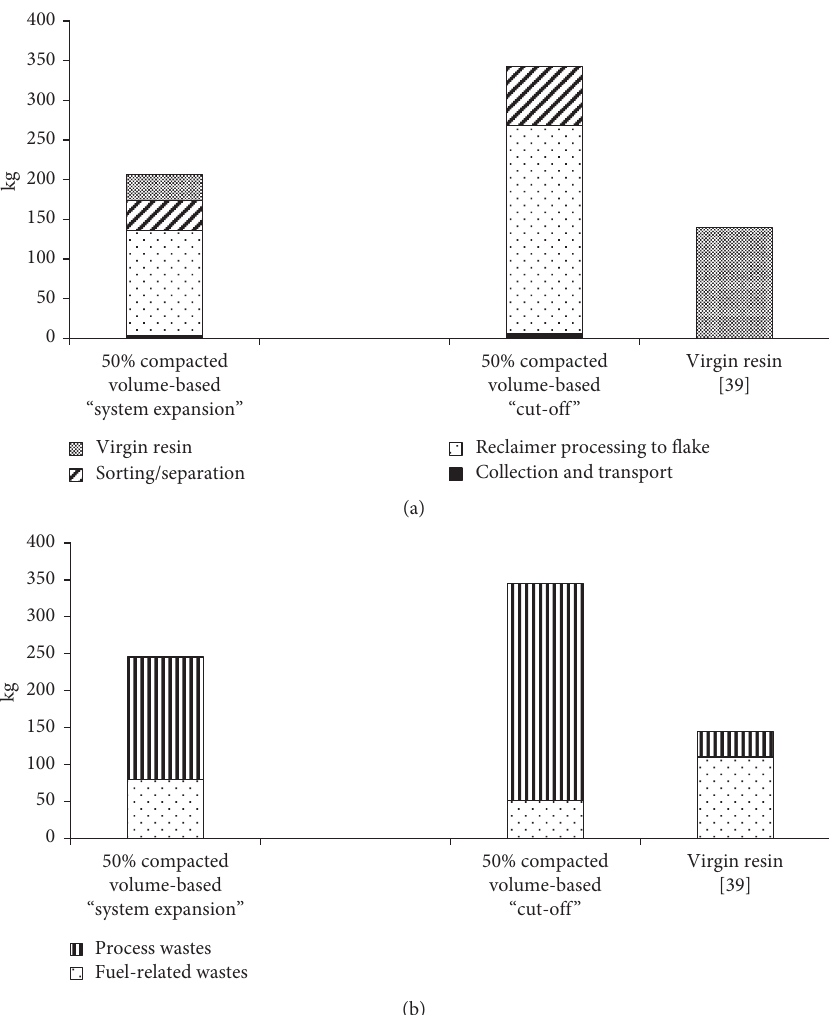
Figure 6: Solid waste results for production of the recycled PETresin flake (kg per ton of resin) by the (a) life cycle stage and (b) solid waste category.